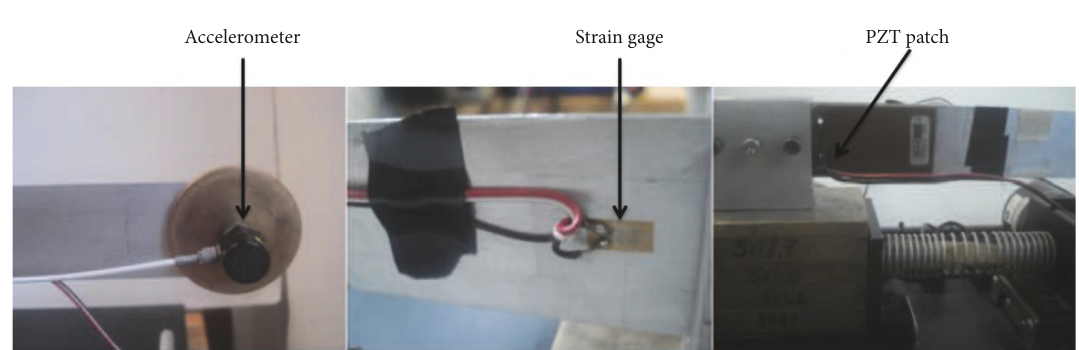
0.010.010.03 m ) − ( x − 0.03 0.200.2 m ( y −